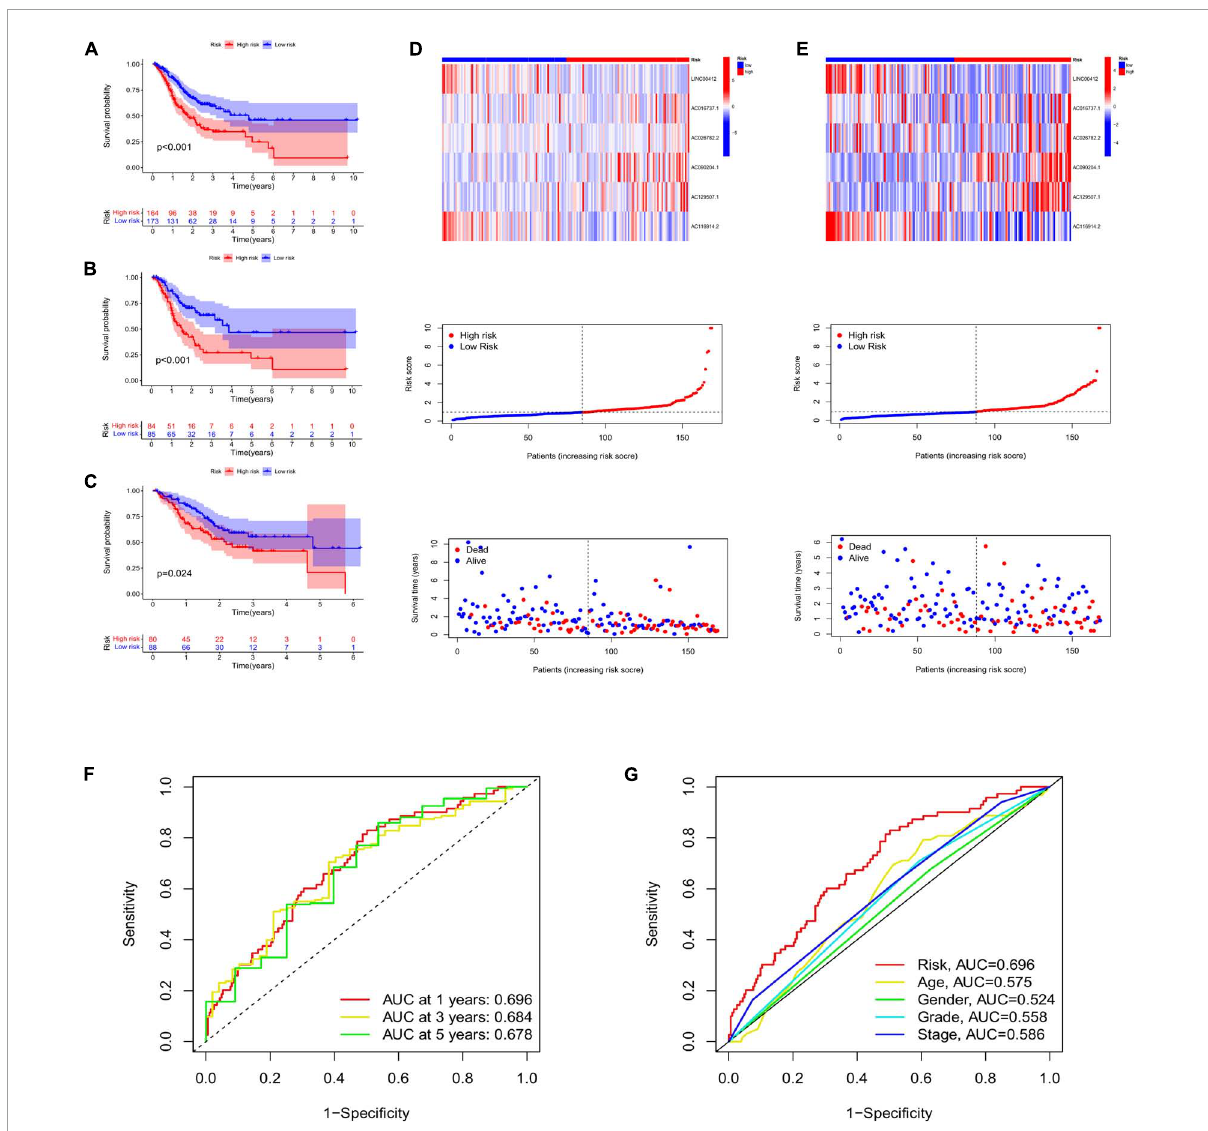
FIGURE3 (A) Survival curve of low- and high-risk groups in all samples. The survival analysis of low- and high-risk groups in the training group (B) and the test group (C) . Heatmap displaying the expression of risk lncRNAs between low- and high-risk groups, and the ranked dot plot showing the risk score distribution in the training group (D) and the test group (E) . (F) The AUC values of 1-, 3-, and 5-year survival. (G) Comparison of AUC between risk signature and age, gender, grade, and stage. AUC, area under the